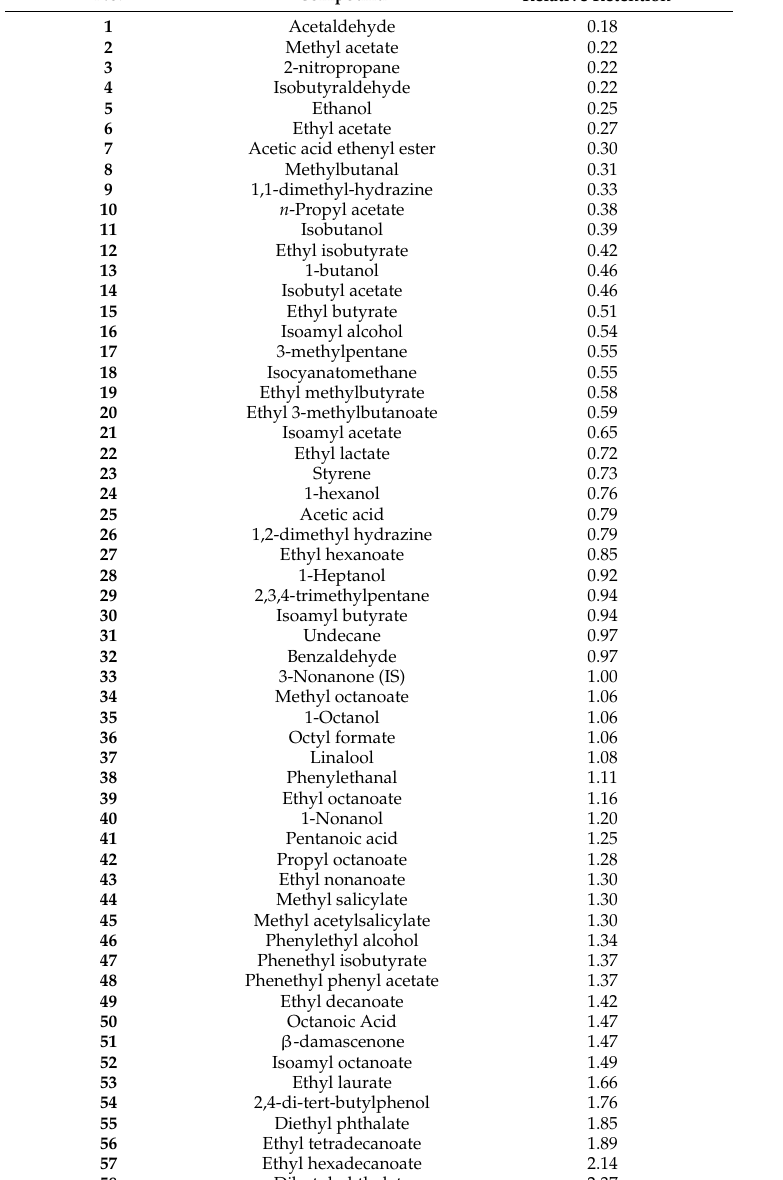
Table 2. Compounds identified in the headspace of Marquette and Frontenac wines using AMDIS and a lab developed mass spectral